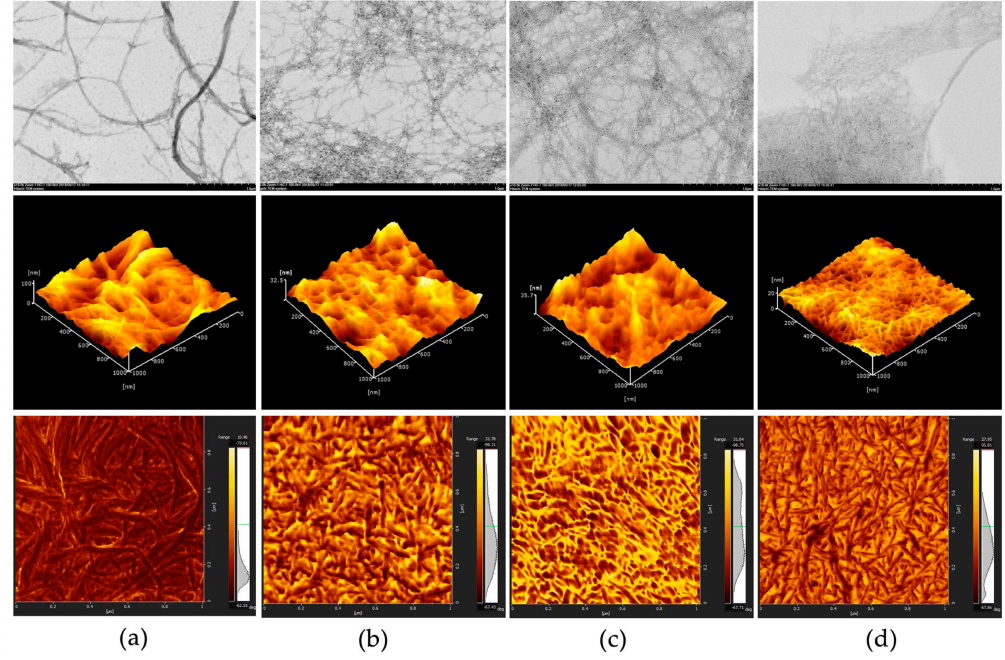
Figure 1. TEM image (top), AFM 3D height image (middle), and AFM phase image (bottom) of ( a ) CNFs; ( b ) TOCNF-1; ( c ) TOCNF-2; and ( d ) TOCNF-3. The scan area of AFM imaging is 1 µ m × 1 µ